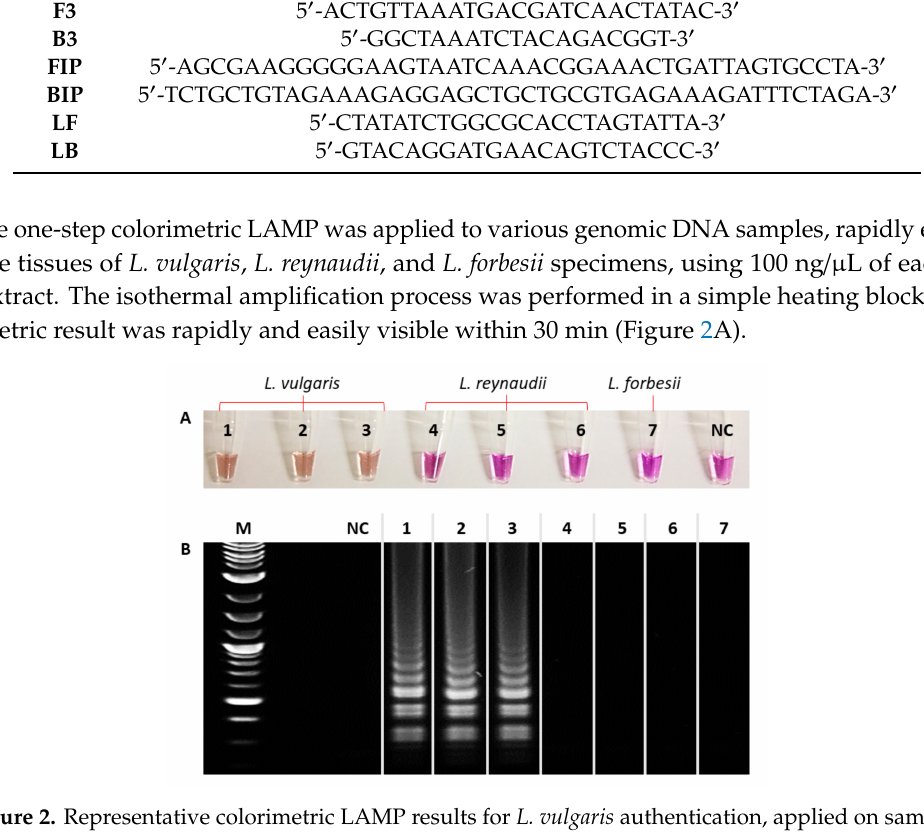
Figure 2. Representative colorimetric LAMP results for L. vulgaris authentication, applied on samples. 1 – 3 : L. vulgaris , 4 – 6 : L. reynaudii , 7 : L. forbesii , NC : pure water. ( A ) Colorimetric result. ( B ) 1% agarose gel; M : molecular weight